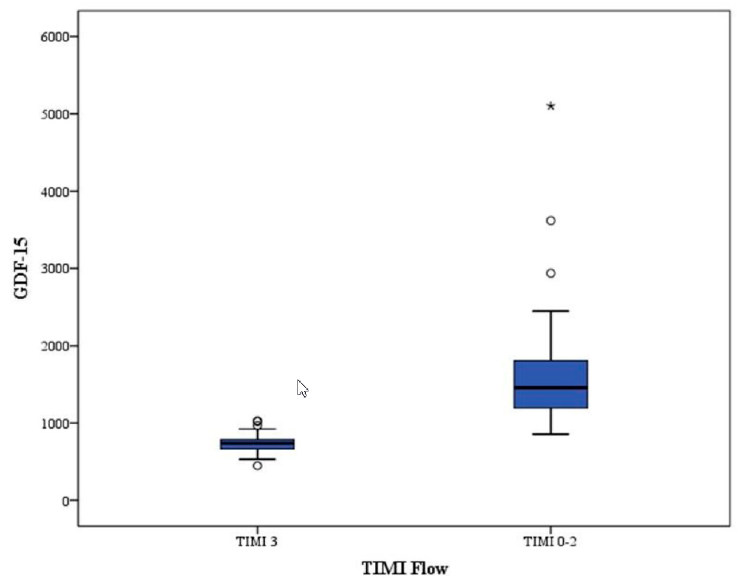
Figure 3. Box-plot between GDF-15 and TIMI Flow.